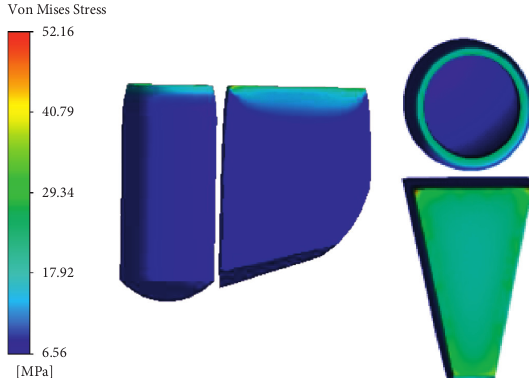
Figure 24: Contour of stress distribution of thermowell and interference device in equilibrium state.